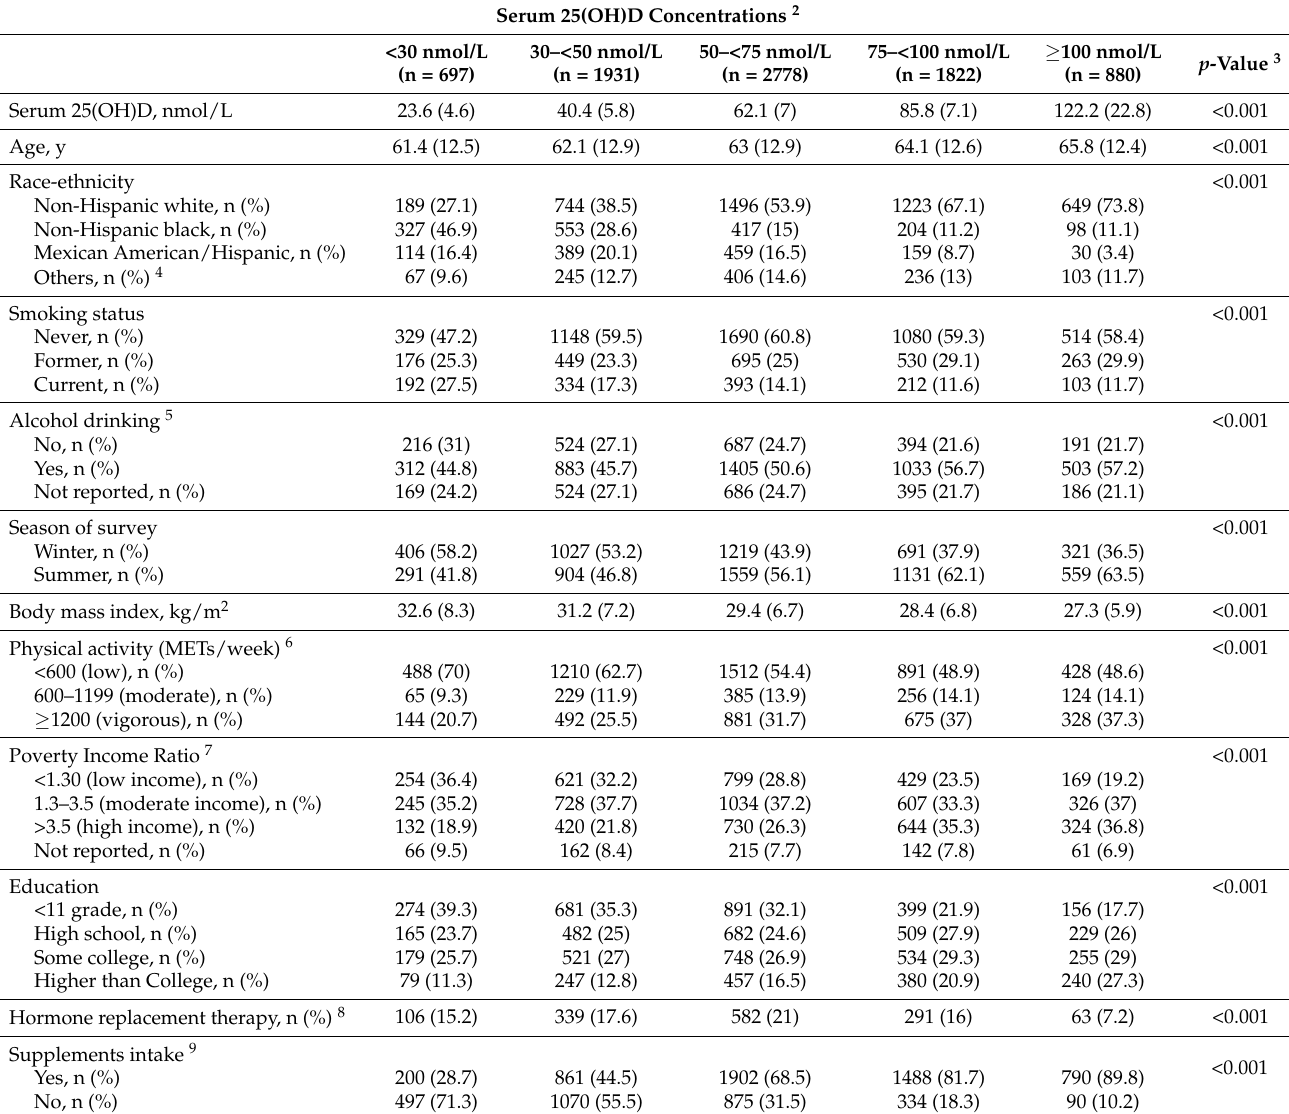
Table 1. Sample characteristics of study population by serum 25-hydroxyvitamin D [25(OH)D] concentrations: National Health and Nutrition Examination Surveys 2001–2014 (n = 8108) 1